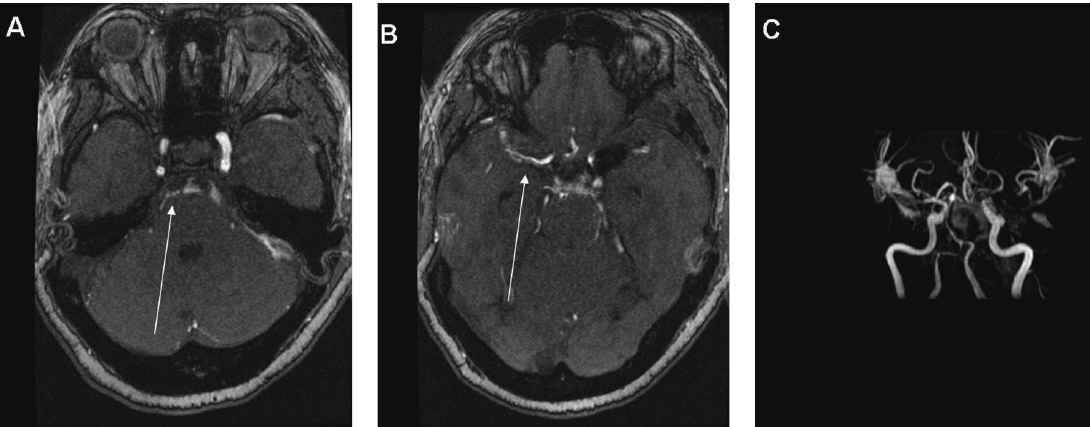
Figure 2: Postbleed day 5 MRI with TOF angiography. MRI = magnetic resonance imaging and TOF = time of flight. (A) Axial TOF sequence at the level of the pons displaying severe basilar artery spasm (white arrow). (B) Axial TOF sequence at the level of the mesencephalon displaying severe right middle cerebral artery vasospasm (white arrow). (C) Three-dimensional TOF reconstruction of the circle of Willis displaying severe spasm of the basilar artery trunk and the middle cerebral arteries bilaterally. The vasospasm is severe enough to prevent TOF signal from identifying the distal basilar and the left proximal middle cerebral